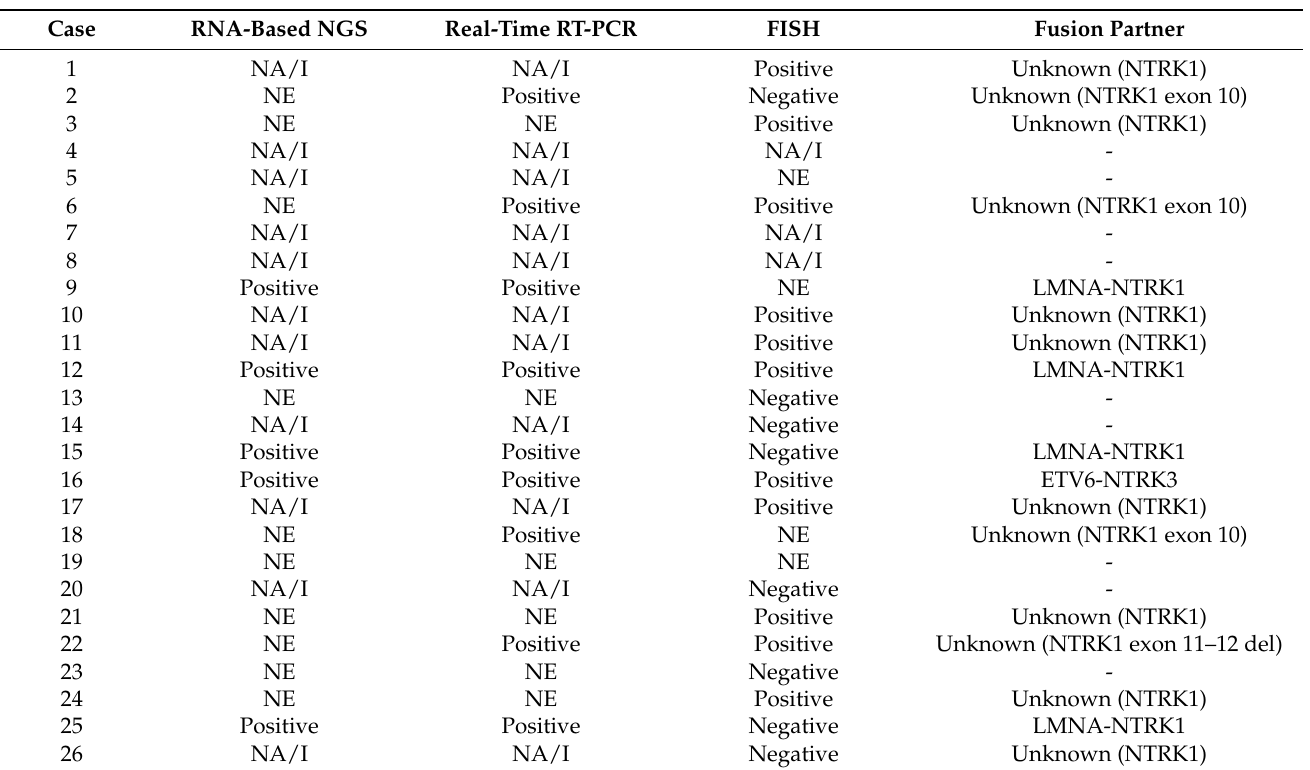
Table 3. Molecular features of the atypical Spitz tumors with positive pan-TRK